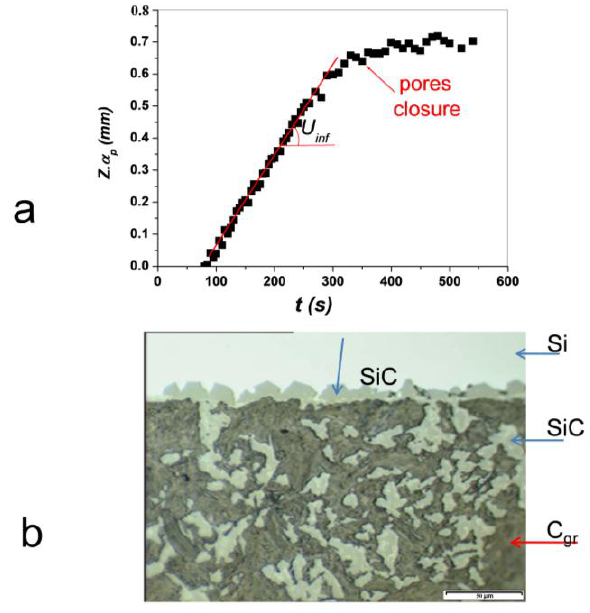
Figure 15. Infiltration of porous graphite (pore volume fraction α p = 0.15) by molten silicon. ( a ) Variation with time of the quantity Zα p where Z is the infiltration distance (Z = h in Equations (7) and (8)). ( b ) Reacted interface and infiltrated zone